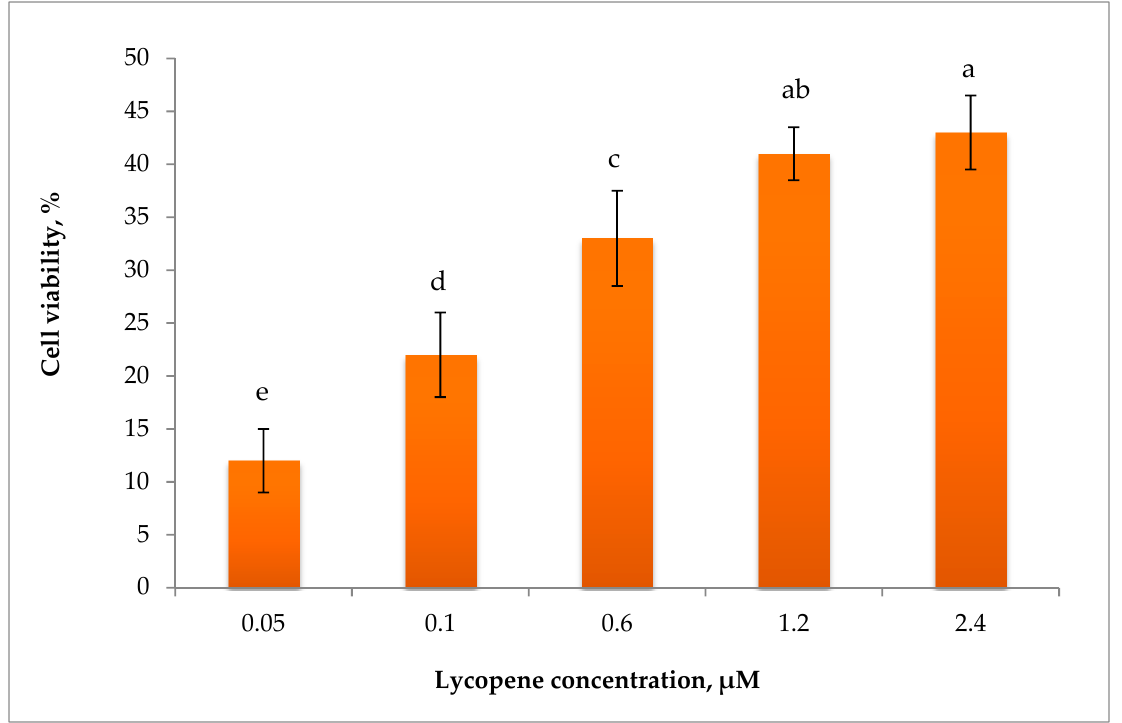
Figure 5. The effect of lycopene on intracellular ROS generation in a rat glioblastoma cell culture. The effect increases depending on the concentration. The greatest effect (42%) was determined using the maximum investigated concentration of 1.2–2.4 µ M. While it is known that the production of reactive oxygen species involves healthy cell signaling pathways and the alteration in redox status may result in the development of cancer, reactive